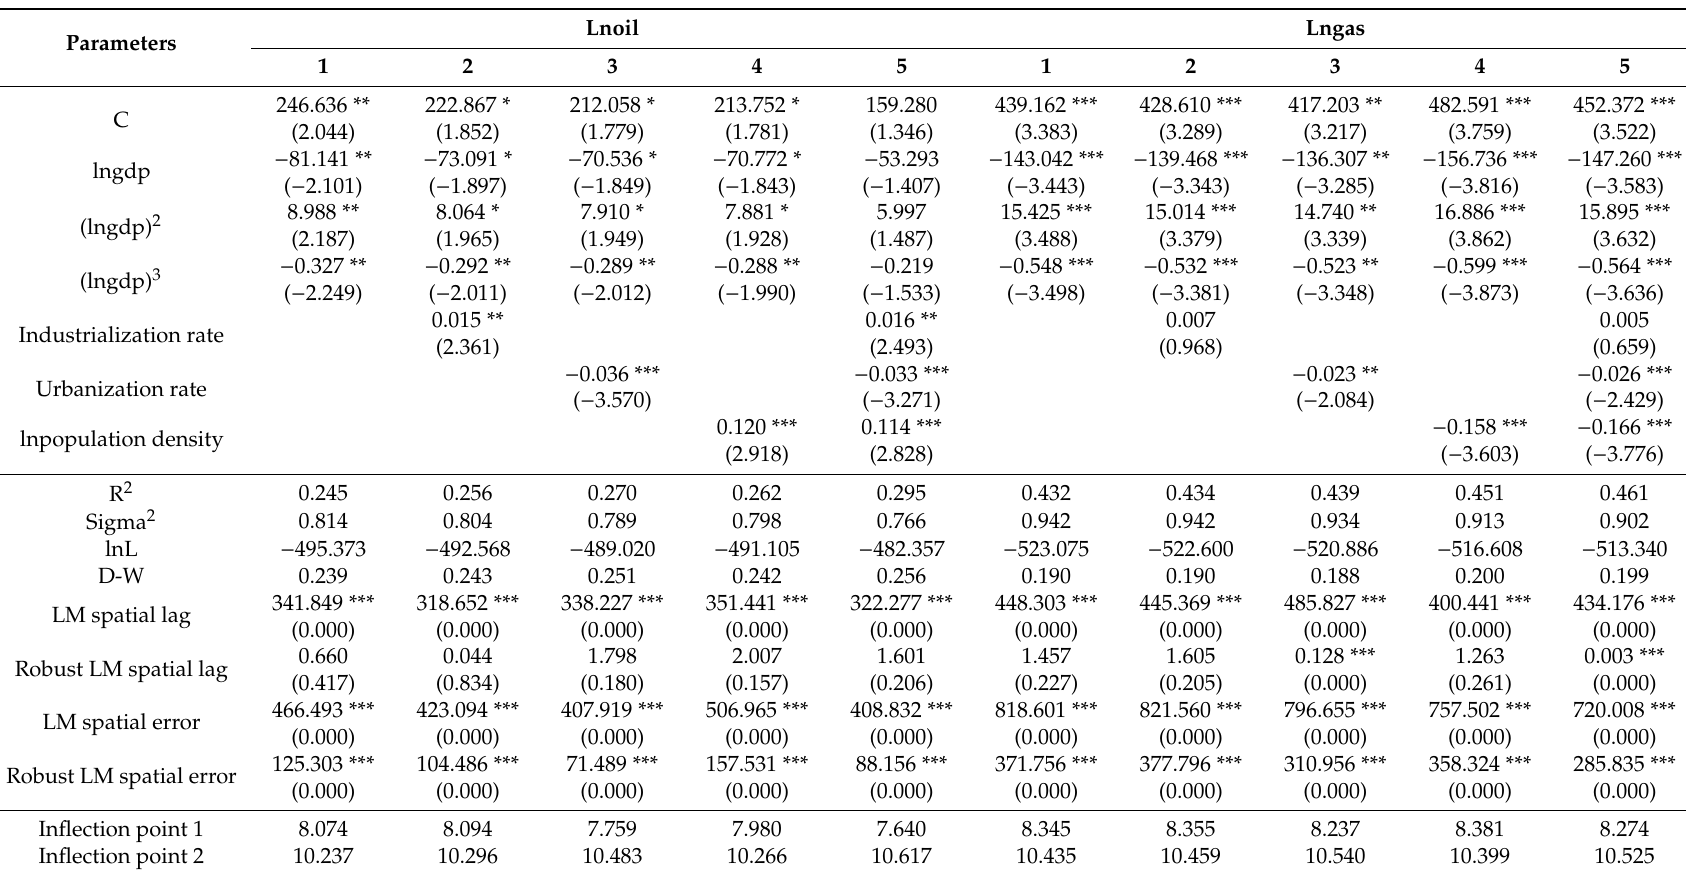
Table 5. Energy consumption EKC panel data estimation